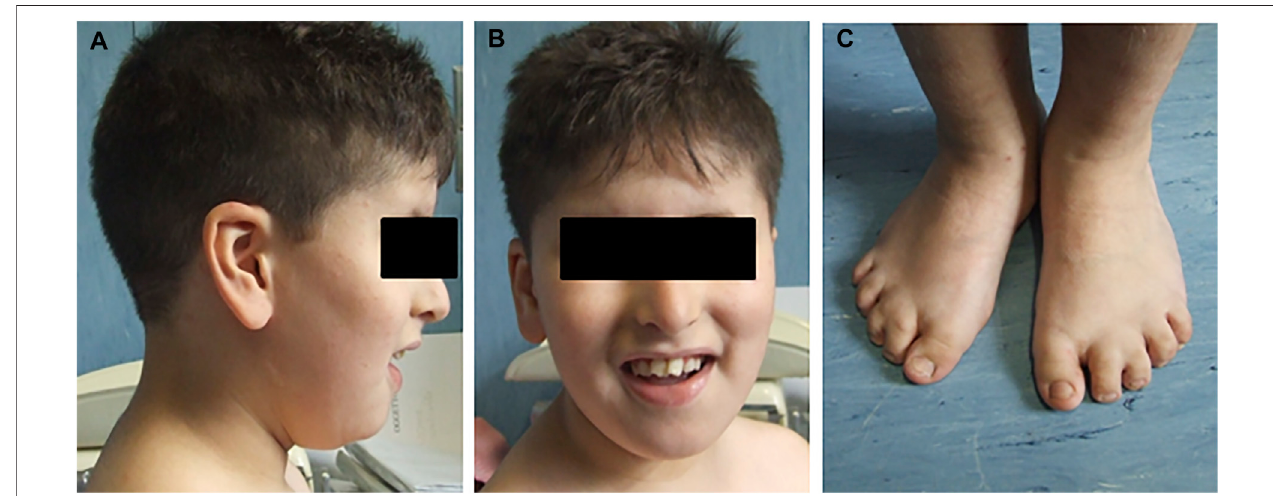
FIGURE 1 | Pictures report some clinical characteristics of the proband. (A) Facial dysmorphisms, beaked nose, and large ears. (B) Dental abnormalities. (C) Bilateral brachydactyly and syndactyly between II and III toes fi